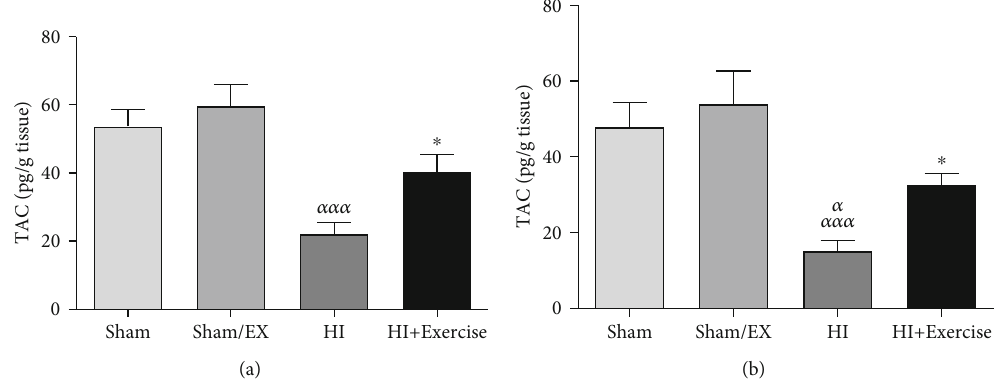
Figure 4: E ff ect of exercise during pregnancy on TAC levels in female (a) and male (b) pups after HI. HI: hypoxia-ischemia. ααα P < 0 : 001 as compared with the sham and sham/EX. ∗ P < 0 : 05 as compared with the HI. Data are expressed as the mean ± S : E : M : ( n = 10 ).